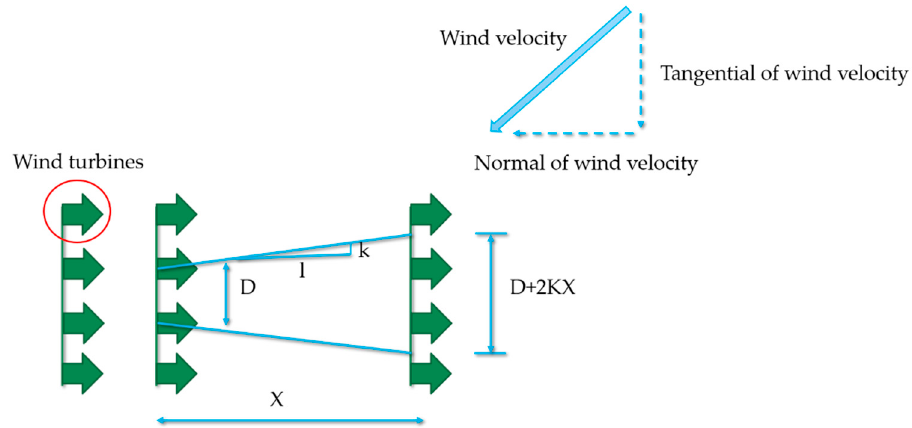
Figure 5. Schematic diagram of the wake effect based on wind direction developed from [11].